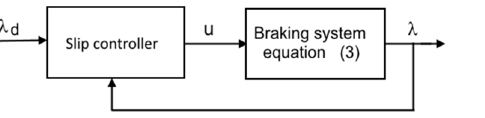
Figure 5. The slip feedback control system where the slip controller is replaceable with any of the following designed controllers.